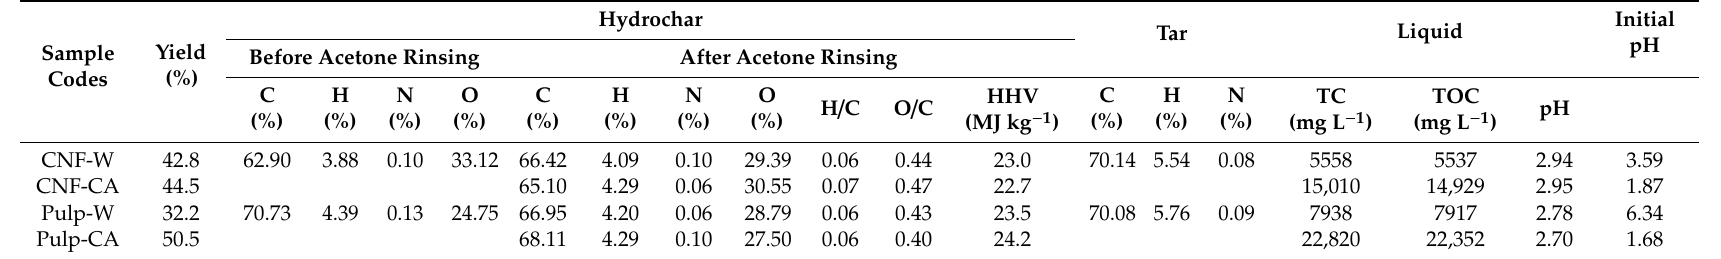
Table 1. Yield, elemental composition, and